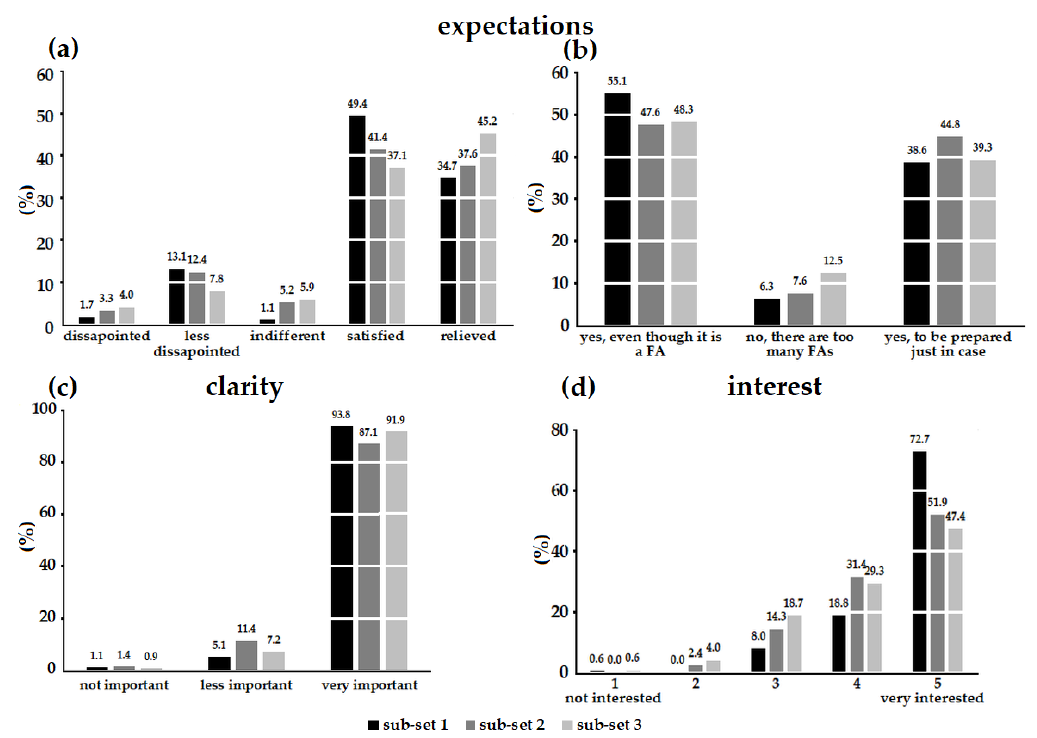
Figure 9. The distribution of results in sub-sets for questions Q13 to Q16 regarding the expectations in case of false alarms ( a ) and issuing messages although the probability of a tornado is low ( b ), how important is the word tornado to be clearly specified in a warning message ( c ), and the respondents’ interests in tornadoes as severe/extreme phenomena ( d ).